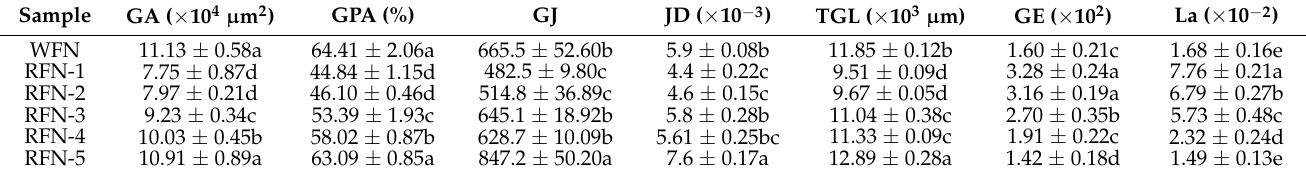
Table 7. Quantitative analysis of the gluten network in the different RFN samples determined by AngioTool software.